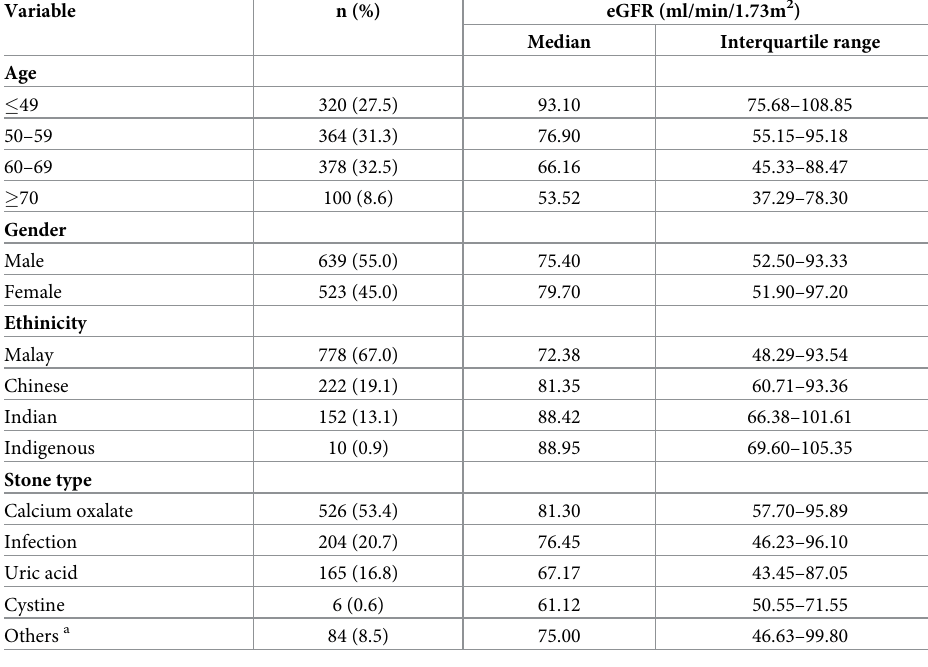
Table 1. The estimated glomerular filtration rate of stone